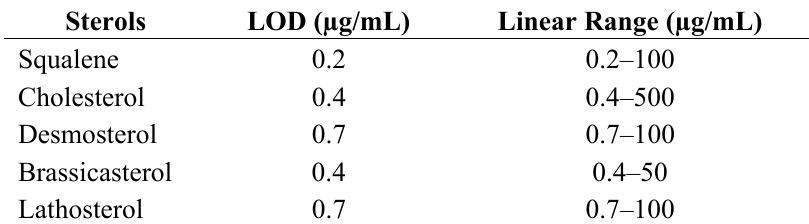
Table 1. Method sensitivity (the limit of